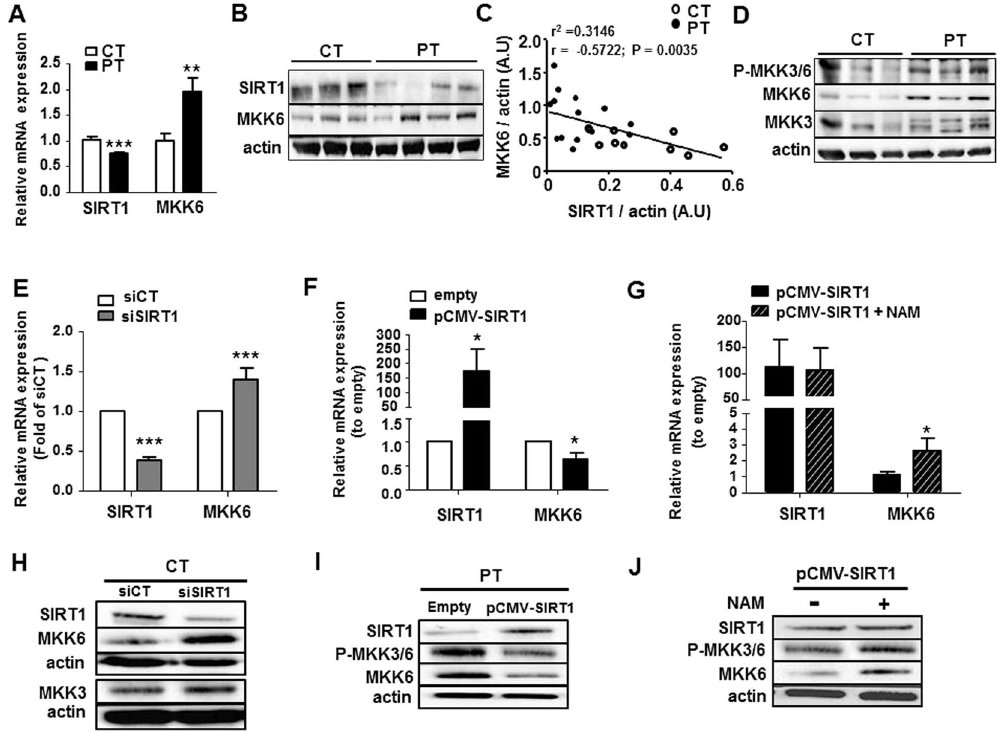
Figure 6. SIRT1 defect increased pMKK3/6 by increasing MKK6 levels. The SIRT1 and MKK6 mRNA (A) and protein (B) expression levels in CT-and PT-ECFC were assessed via RT-qPCR and Western blot analysis, respectively. ( A ) The impact of PT on the mRNA level (relative expression to CT; N = 13 CT vs. 16 PT). ( B ) The impact of PT on the protein level (relative expression to actin; N = 18 CT vs. 26 PT, representative blot). ( C ) The correlation between MKK6 and SIRT1 protein expression levels. Every plot represents a single sample collected from a patient (N = 24). ( D ) Western blot analysis of MKK3/6 activation in CT- and PT-ECFC was performed by the determination of phosphor-MKK3/6, MKK3 and MKK6 (N = 118 vs 28). ( E–J ) The impact of SIRT1 modulation on the activation of MKK3/6. SIRT1 and MKK6 mRNA (E–G) and protein (H–J) expression levels, along with MKK3/6 phosphorylation, were assessed via RT-qPCR and Western blot analysis, respectively. ( E , H ) The impact of SIRT1 silencing on the mRNA and protein expression of CT-ECFC (relative expression to scrambled; N = 12). ( F,I ) The impact of SIRT1 overexpression on mRNA and protein expression in PT- ECFC (relative expression to empty; N = 7 and 11, respectively). ( G,J ) The impact of NAM on mRNA (relative expression to empty, N = 8) and protein expression (relative expression to SIRT1-transfected cells; N = − 6–9) in PT-ECFC overexpressing SIRT1. The data for all of the bar graphs are presented as the means ± SEM. (Statistical analysis: t-test; * p < 0.05, ** p < 0.01, *** p < 0.001). All blots correspond to representative images of blot